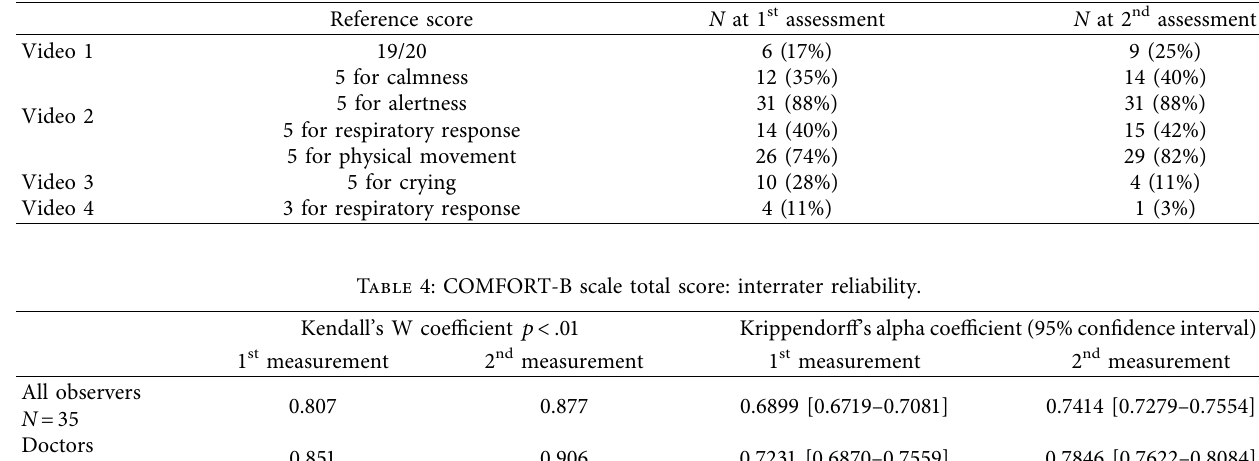
Table 3: COMFORT score in relation to reference videos (training website: https://comfortassessment.nl/, [14]).